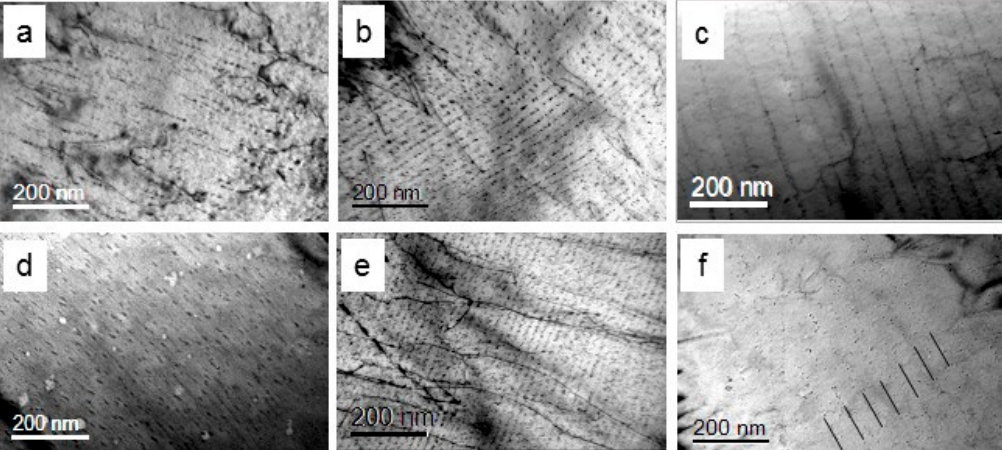
Figure 5. TEM bright field images of precipitate arrangements in ferrite: ( a ) HFT/600/15, ( b ) HFT/650/15, ( c ) LFT/600/15, ( d ) HFT/600/30, ( e ) HFT/650/30, ( f ) LFT/600/30.